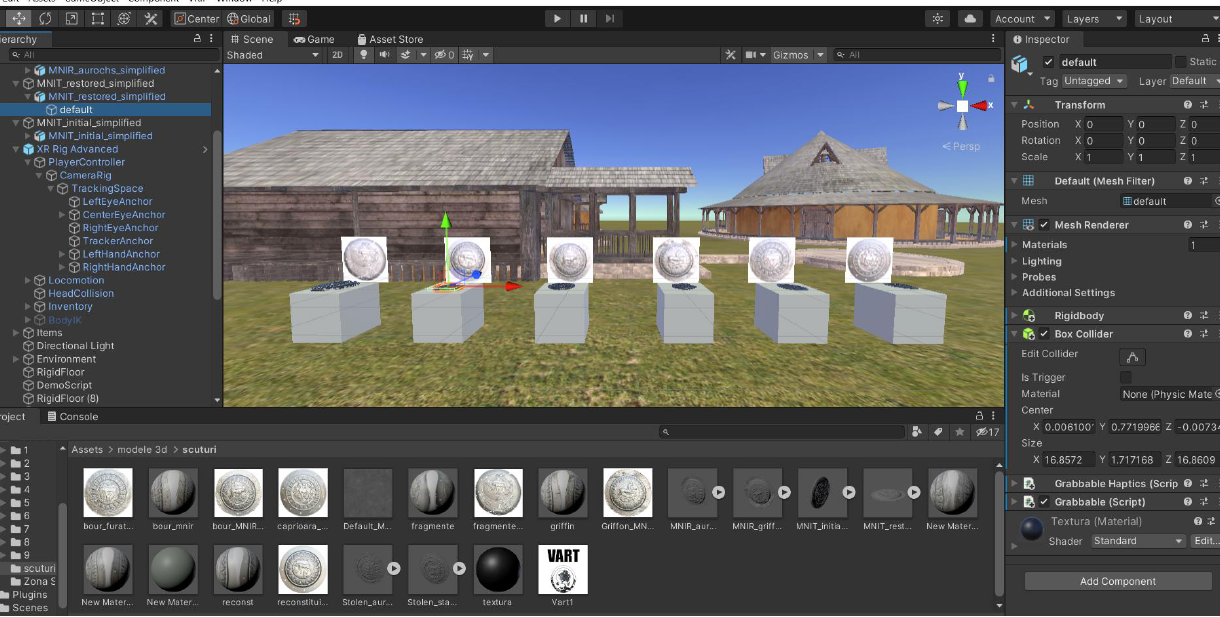
Figure 24. Overview of the VR application developed in